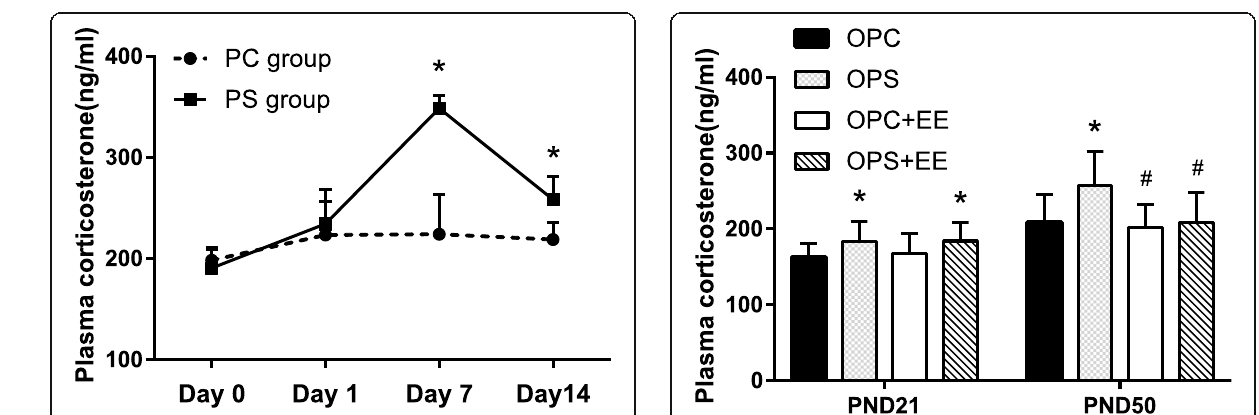
Fig. 3 The comparison among OPC, OPS, OPC&EE and OPS&EE in plasma corticosterone level. Differences in corticosterone level were detected among OPC, OPS, OPC&EE, and OPS&EE. The plasma corticosterone level is the highest in OPS group, the lowest in the OPC&EE group. Data were respectively analyzed using One-way ANOVA, followed by LSD-t test to make comparison at the two different groups. Number of animals in each offspring group = 16